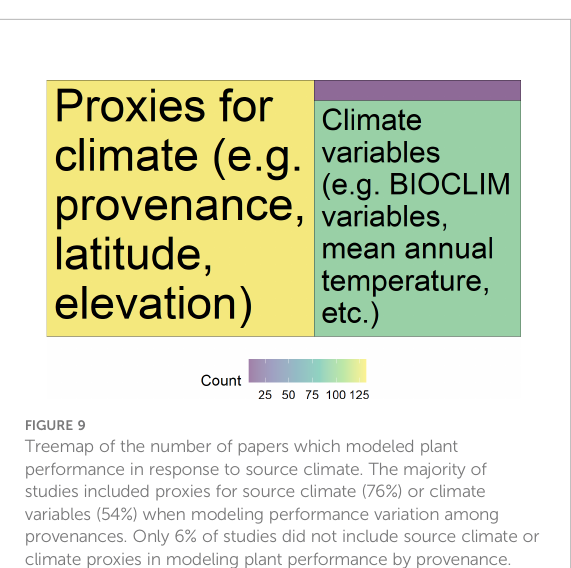
FIGURE 9 Treemap of the number of papers which modeled plant performance in response to source climate. The majority of studies included proxies for source climate (76%) or climate variables (54%) when modeling performance variation among provenances. Only 6% of studies did not include source climate or climate proxies in modeling plant performance by